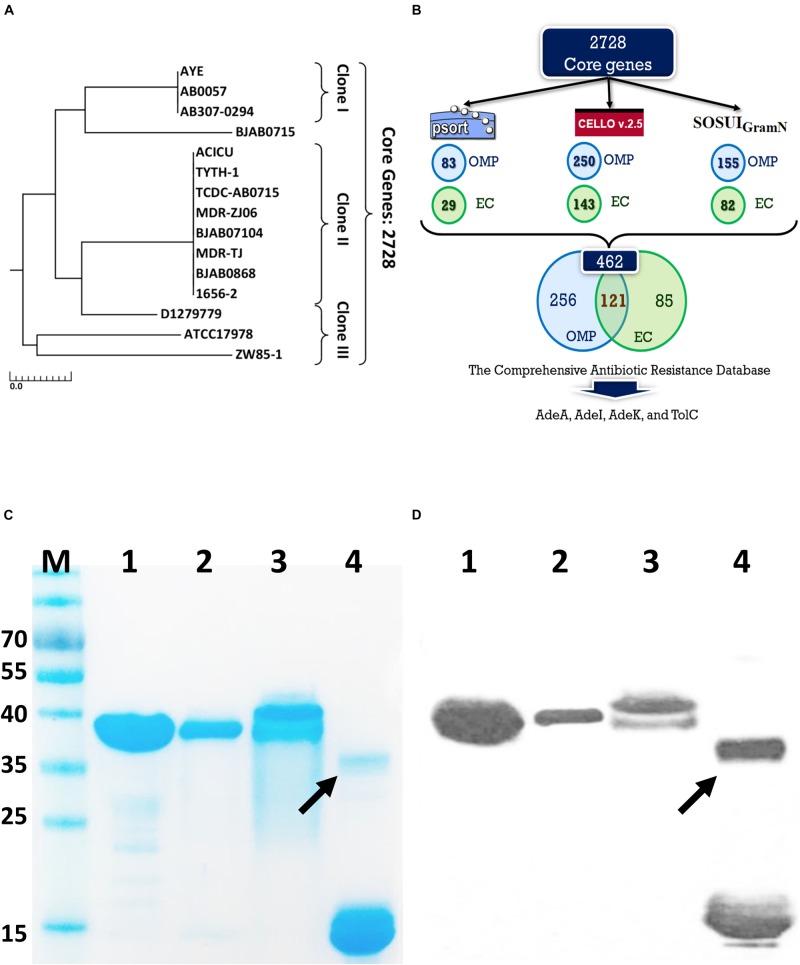
A rational strategy for potential antigen identification and verification from A. baumannii genomes. (A) The phylogenetic lineage of 15 completely sequenced A. baumannii strains analyzed in this study was constructed by the neighbor-joining method performed in MEGA7. Homology core genes were analyzed using the web-based MBGD tool. (B) Bioinformatics tools including PSORTb 3.0.2, CELLO2GO, and SOSUI-GramN were utilized to identify 462 non-redundant outer membrane or extracellular proteins from 2728 core genes. Four antimicrobial-resistant genes associated with efflux pumps were identified in the 462-protein datasets based on Comprehensive Antibiotic Resistance Database (CARD) analysis. OMP, outer membrane protein; EC, extracellular protein. (C) Purified proteins were analyzed by 12% sodium dodecyl sulfate-polyacrylamide gel electrophoresis. Lane M-standard protein markers, Lane 1-purified rAdeI protein, Lane 2-purified rTolC protein, Lane 3-purified rAdeK, Lane 4-purified rAdeA protein. (D) Western blot analysis of purified recombinant proteins using mouse anti-His antibody. The arrow indicates dimerization of rAdeA (confirmed by LC-MS/MS).